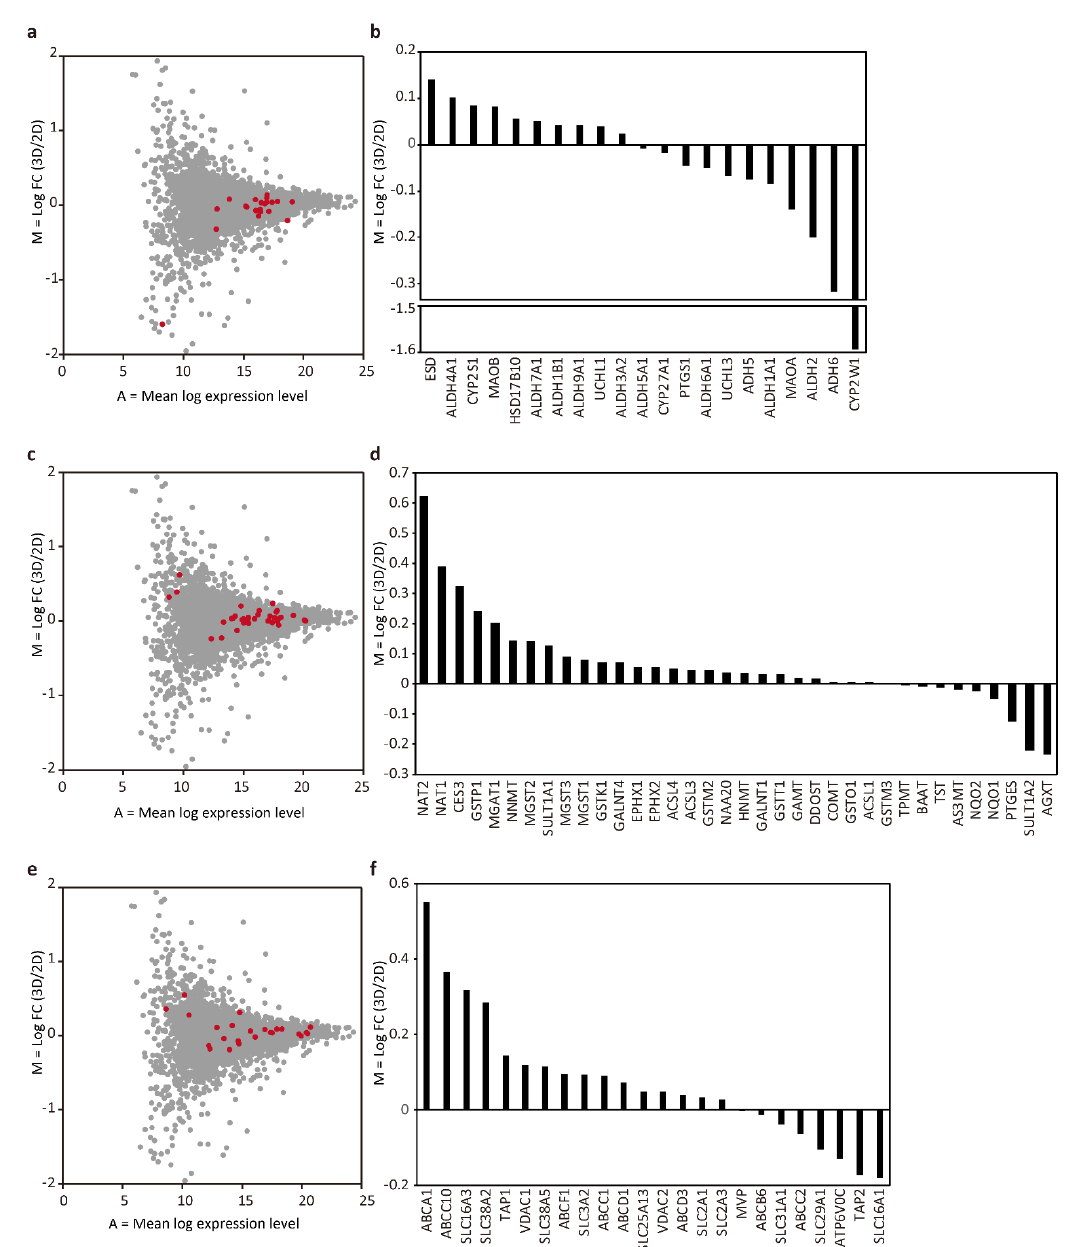
Figure 4. MA plot and bar graph showing log 2 FC of phase I ( a , b ), II ( c , d ), and III ( e , f ) proteins. There were 27 proteins with log 2 FC > 0 and 9 proteins with log 2 FC < 0 among phase II proteins, indicating that many of those proteins, NAT2 in particular (log 2 FC = 0.62), were highly expressed in the tubular liver tissue (Figure 4c,d). NAT2 is an important protein